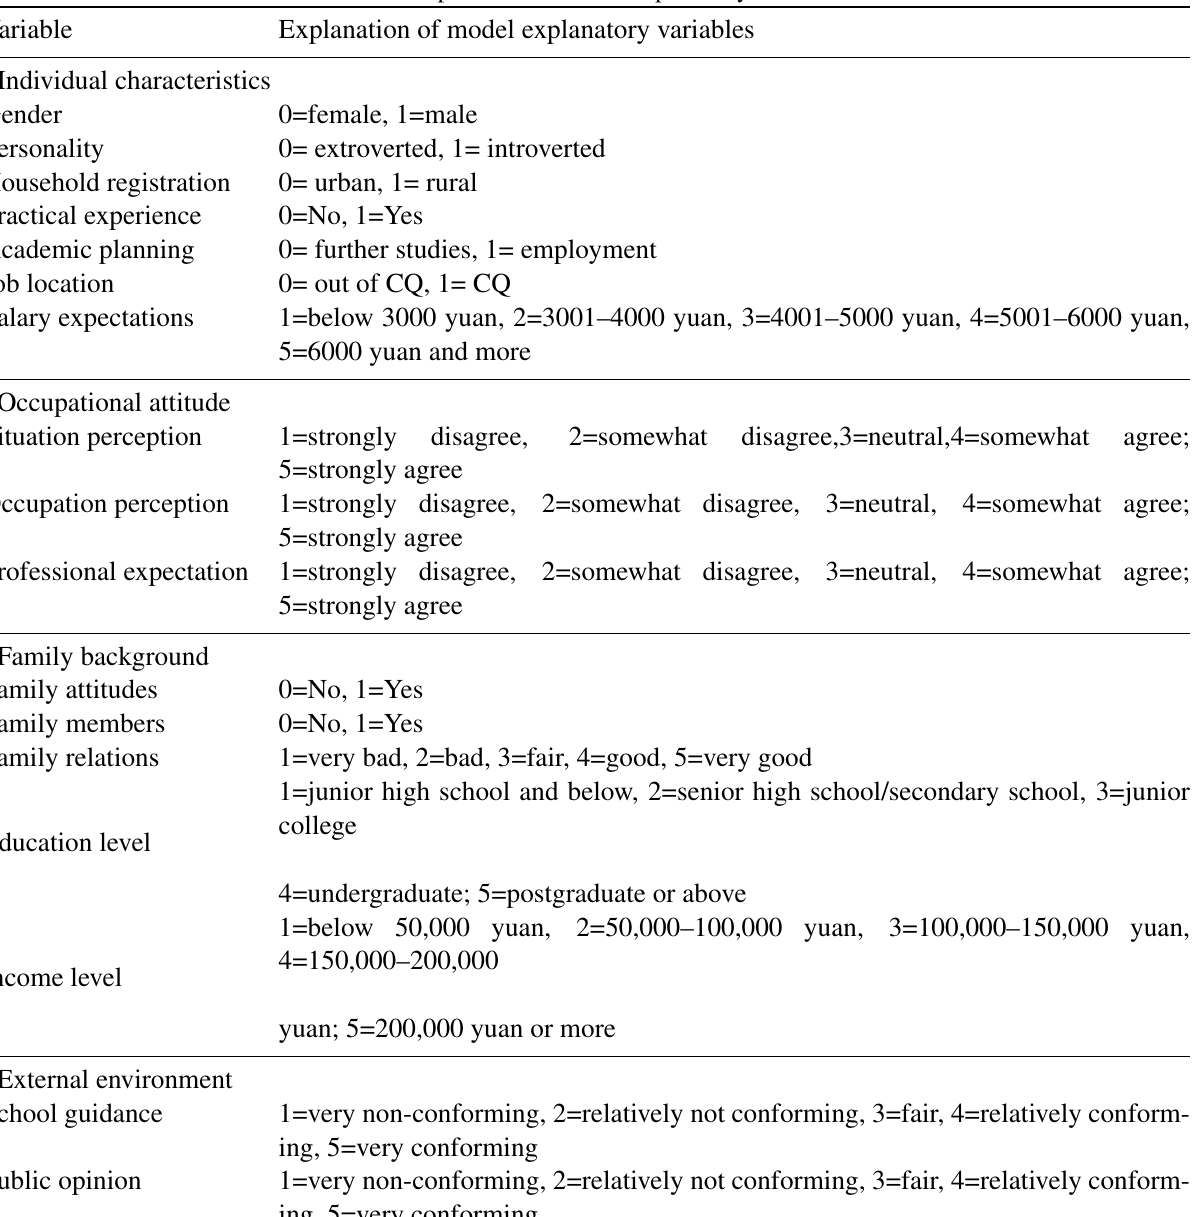
Table 2 Explanation of model explanatory